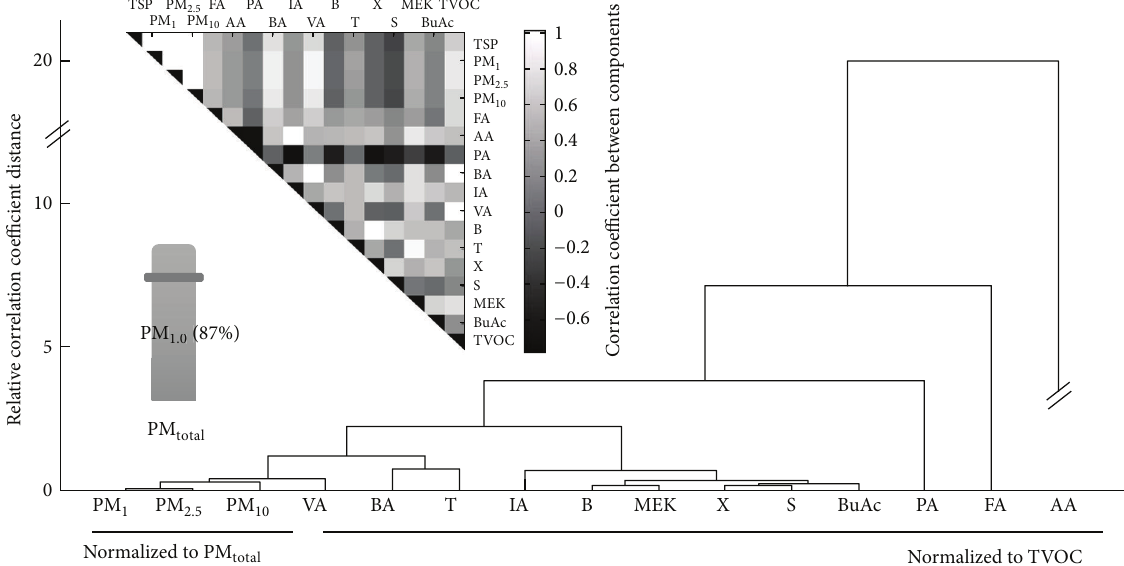
Figure 3: Hierarchical clustering analysis of the concentrations of target compounds obtained from a total of 11 repeat pan fryings of mackerel samples (note: PM 1 , PM 2.5 , and PM 10 were normalized to PM total and volatile organic compounds (VOCs) were normalized to